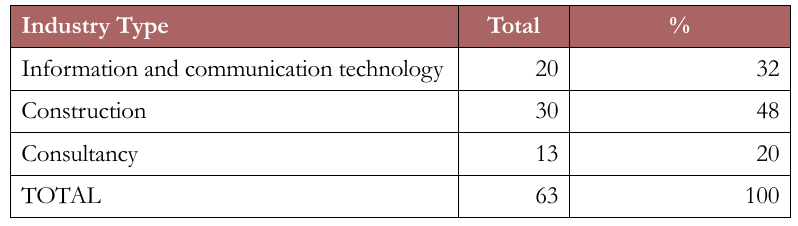
Table 4. Industry